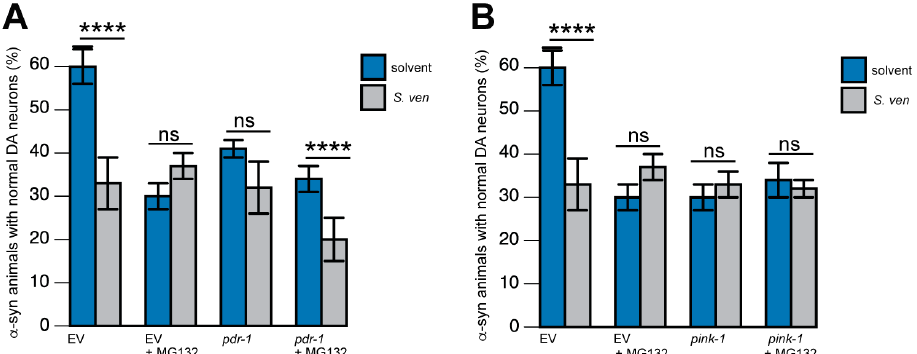
Figure 3. Epistatic regulation of enhanced α -synuclein toxicity by pink-1 . ( A , B ) Combinations of dopaminergic stressors (such as MG132 and/or Streptomyces venezuelae , or S. ven ) were applied to transgenic C. elegans , which was also expressed human α -syn in DA neurons. ( A ) Along with knockdown of pdr-1 (RNAi), a more severe DA neurodegenerative phenotype was observed if compared to combinations of just two stressors at a time; ( B ) In animals where pink-1 (RNAi) was knocked down, enhanced neurodegeneration was not observed. Instead, all of the combinations of stressors yielded similar levels of neurodegeneration with the depletion of pink-1 , which was thereby indicative of a common mechanism revealed by putative epistatic relationships.